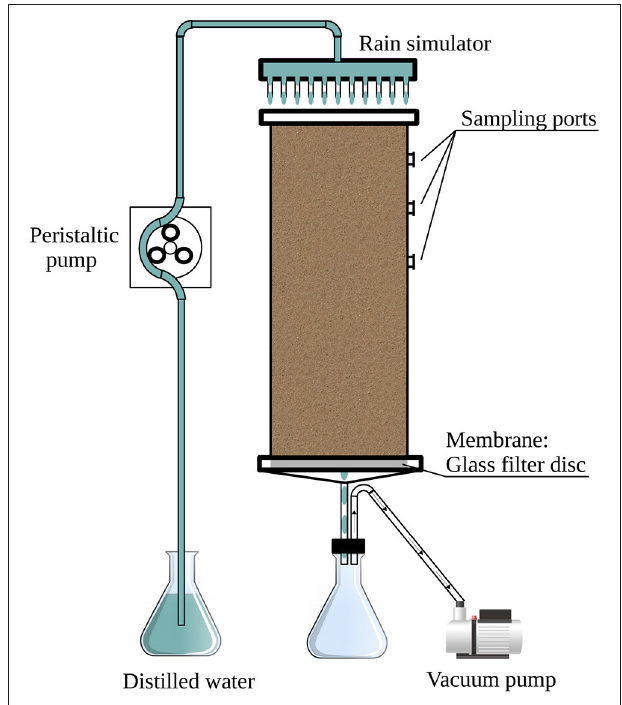
FIGURE 1 | Schematic representation of the mesocosm setup used in this study.